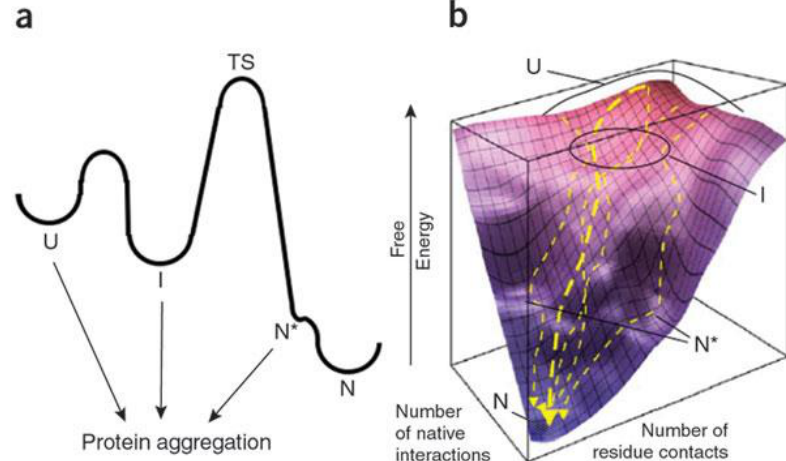
Figure 1. Aggregation can occur from different protein conformations ( a ) kinetic profile; ( b ) thermodynamic energy landscape. U = unfolded, I = intermediate, N = native, N* = native-like locally unfolded state with low free energy barrier, TS = transition